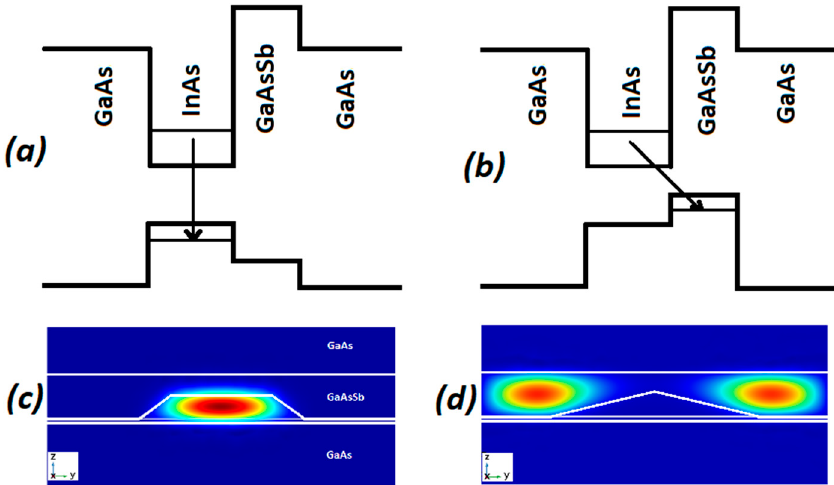
Figure 5. Schematic band lineup ( a ): Type I and ( b ) type II. ( c ) and ( d ) are, respectively, the cross- sectional heavy-hole envelope wave function for X Sb = 6% (truncated pyramidal shape/type I) and X Sb = 22% (full pyramidal shape/type II).